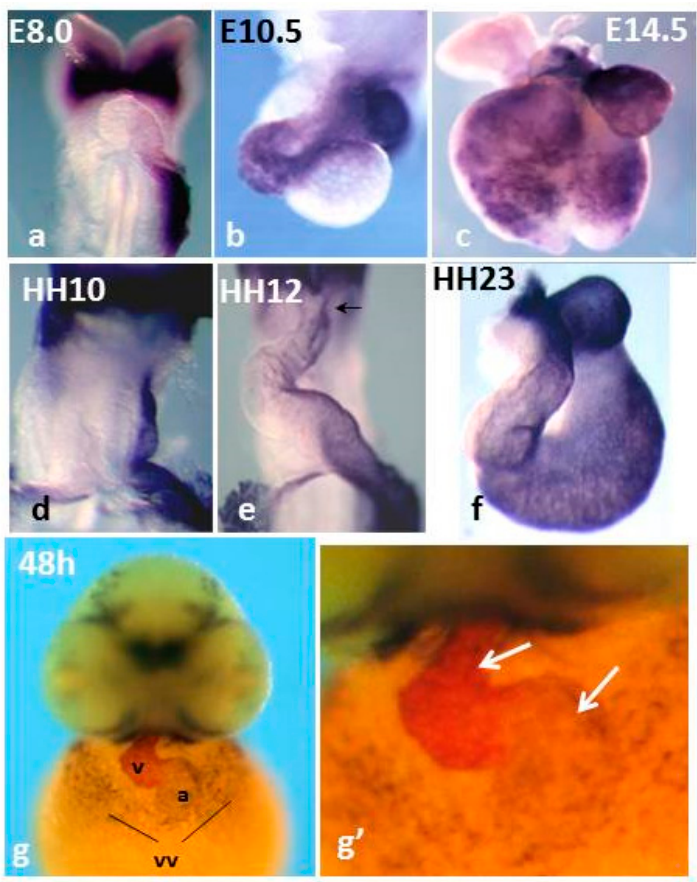
Figure 1. Comparison of Pitx2 mRNA expression in mouse ( a – c ), chicken ( d – f ) and zebrafish embryos ( g , g’ ). Mice and chicken, single in situ hybridization (ISH); zebrafish, double ISH: Pitx2, dark blue, and mlc2v, magenta. Note that in chickens and mice, Pitx2 delineates the left heart primordium and its remodeling. In developing zebrafish hearts, Pitx2 expression delineates the common atrium and is regionalized in the ventricles. vv: vitelline veins. Panels a – f are reproduced with permission from [85].